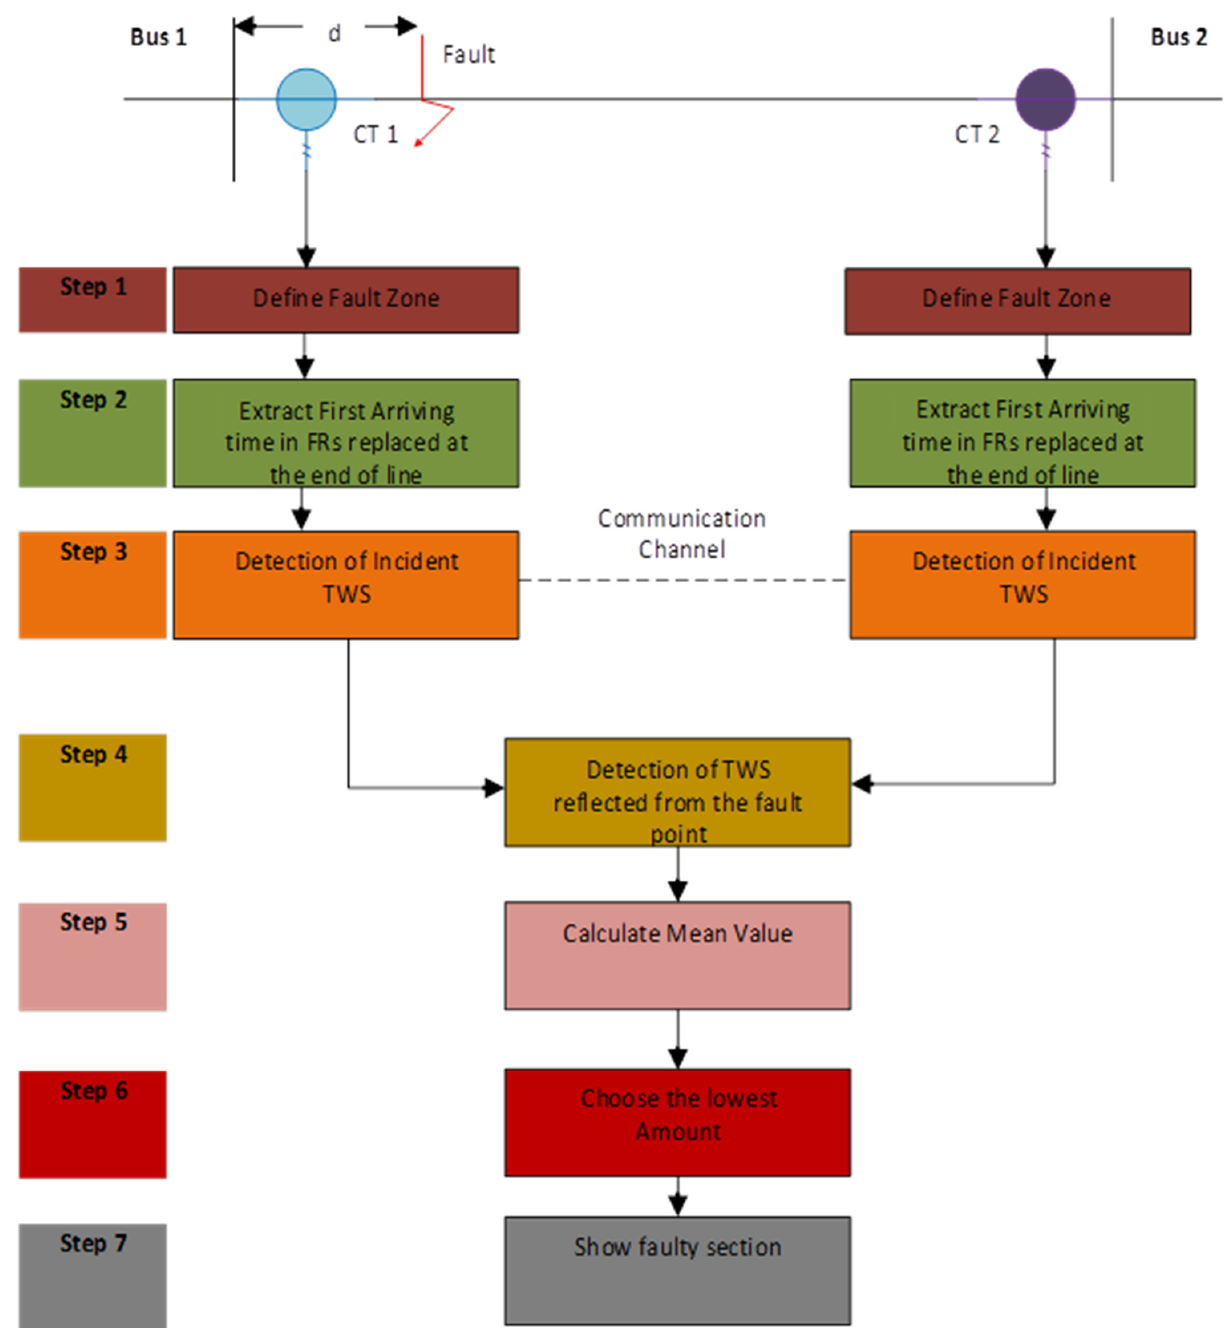
Figure 6. Flowchart of the proposed DWT methodology.